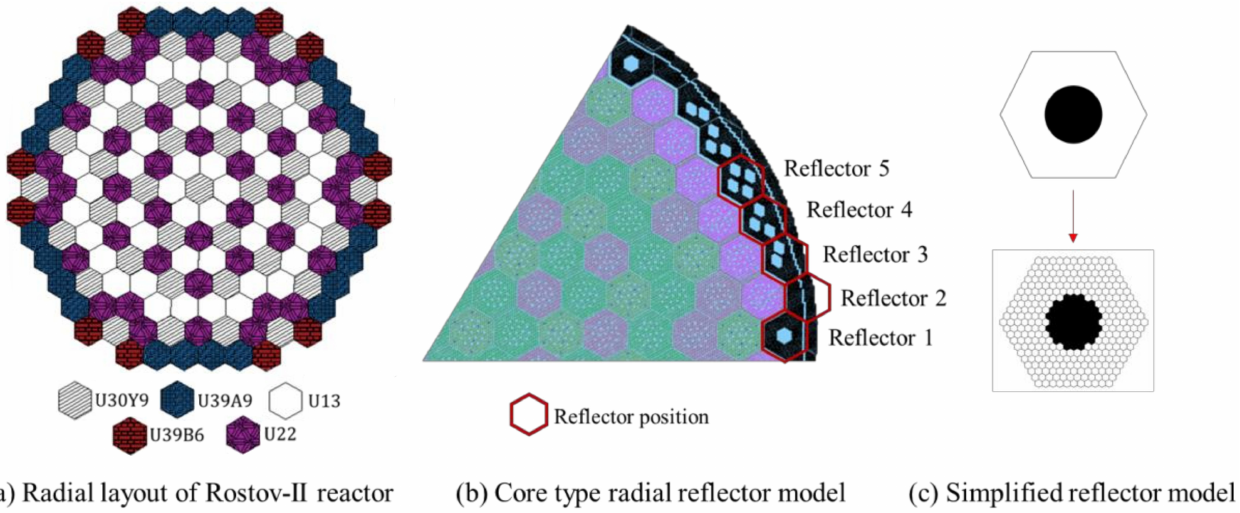
Figure 7. Radial layout of Rostov-II nominal radial reflector